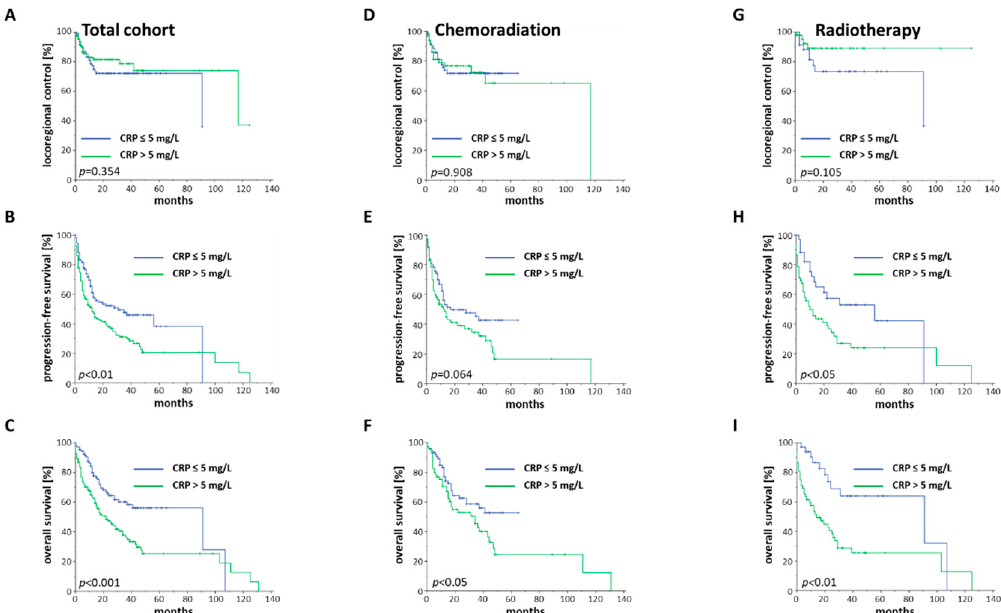
Figure 4. LRC, PFS and OS of elderly HNSCC patients stratified by the baseline CRP concentration.